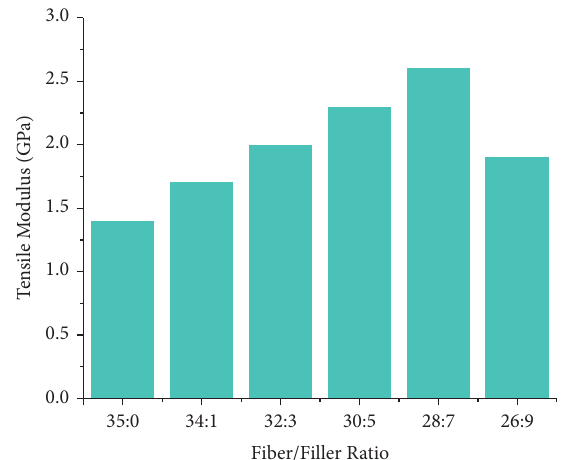
Figure 7: Effect of fibre/filler loading on tensile modulus for epoxy resin/madar fibre/sugarcane bagasse ash composites.